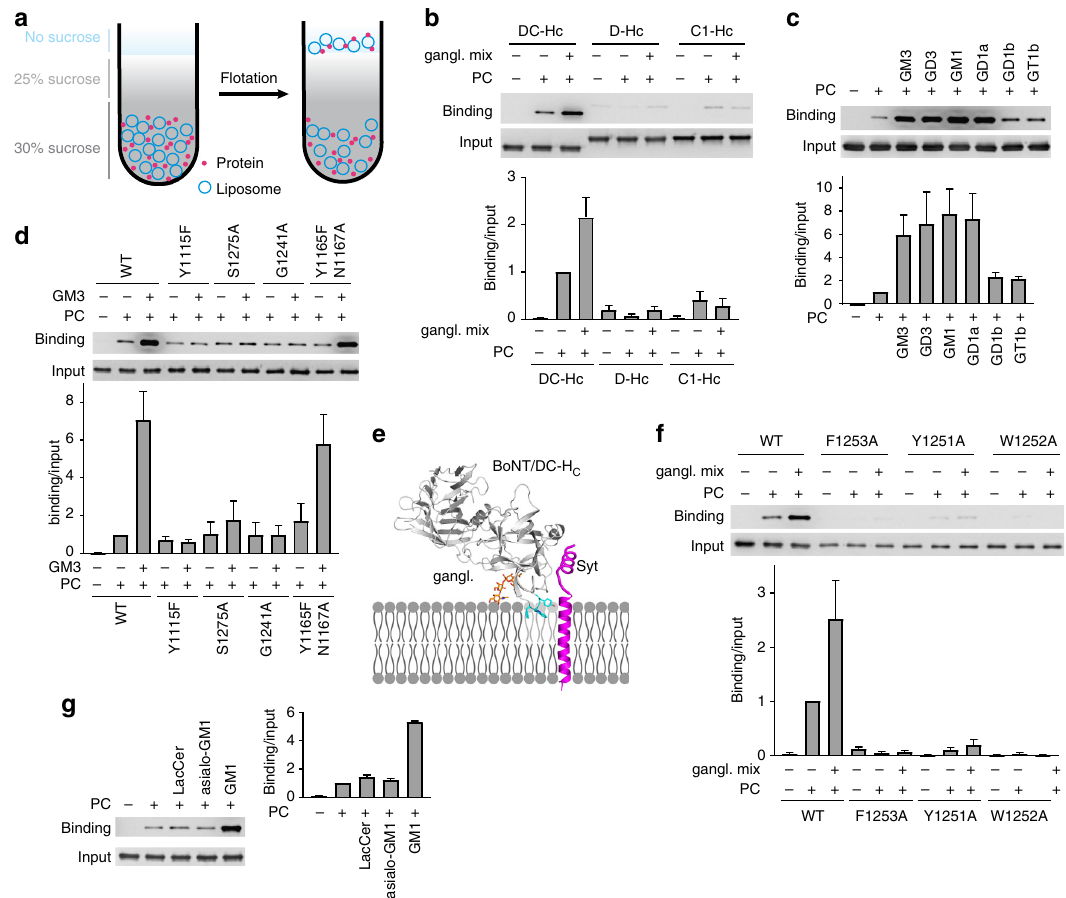
Fig. 5 Binding of BoNT/DC-H C to ganglioside-containing liposomes. a A schematic drawing of the liposome fl otation assay. b Experiments were carried out as depicted in a . Liposomes containing PC alone or PC plus a brain ganglioside mixture (gangl. mix, 1%) were incubated with HA-tagged BoNT/DC-H C , BoNT/D-H C , or BoNT/C1-H C . Samples were centrifuged for 1 h at 240,000 × g in a sucrose gradient. Liposome fractions that fl oated to the top of the gradient were collected and subjected to immunoblot analysis. Samples without liposomes served as a negative control. BoNT/DC-H C showed a basal level of binding to PC liposomes. Adding gangliosides increased binding of BoNT/DC-H C to liposomes. BoNT/D-H C and BoNT/C1-H C did not show detectable binding to liposomes under the same assay conditions. c Experiments were carried out as described in b , except with indicated individual ganglioside species instead of a mixture of brain gangliosides. Both simple gangliosides (GM3 and GD3) and complex gangliosides (GM1 and GD1a) enhanced binding of BoNT/DC-H C to liposomes. GD1b and GT1b also increased binding of BoNT/DC-H C , but to a much lesser degree than GM1 and GD1a. d Experiments were carried out as described in b , with the indicated mutants of BoNT/DC-H C and GM3-loaded liposomes. Mutations at the GBS (Y1115F, S1275A, and G1241A) abolished ganglioside-mediated binding to liposomes, as they showed similar levels of binding in PC alone and GM3-containing liposomes. In contrast, Y1165F/N1167A did not affect ganglioside-mediated binding to liposomes. None of these mutations reduced binding of BoNT/DC-H C to PC liposomes compared to WT. e Model of BoNT/DC-H C on plasma membranes. BoNT/DC is anchored onto plasma membranes by both Syt-binding and GBS – sialic acid interactions, putting the protein at an ideal angle to allow the extended loop (blue) to penetrate into the lipid membrane. f Experiments were carried out as described in b . Mutating any one of the three residues at the tip of the extended loop (F1253A, Y1251A, or W1252A) abolished binding of BoNT/DC-H C to PC liposomes. Adding gangliosides did not rescue binding. g Experiments were carried out as described in b . Binding of BoNT/DC-H C to liposomes containing LacCer or asialo-GM1 was at similar levels as to PC liposomes, while GM1 increased binding of BoNT/DC-H C . One of three ( b – d , f , g ) independent experiments is shown. Immunoblot was quanti fi ed using ImageJ ( n = 3) and normalized to the levels of BoNT/DC-H C binding to PC liposomes in all panels. Error bars represent standard (Y1115F, S1275A, and G1241A) did not affect pulldown of Syt I SV2. Mutations at the Sia-2 site (Y1165F/N1167A) still pulled